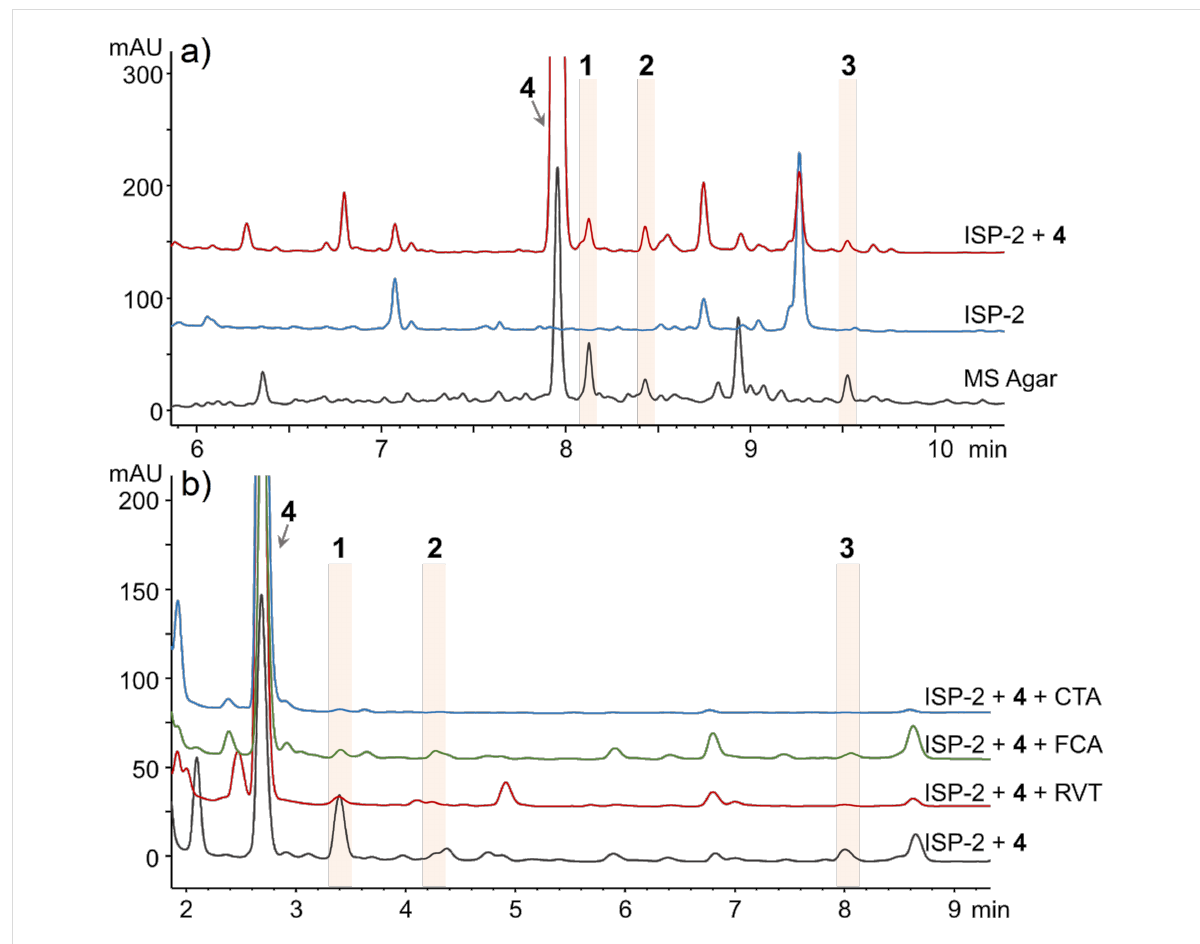
Figure 2: a) The culture in ISP-2 liquid did not produce 1 – 3 , while feeding with 4 restored the production (analytical method A according to Experi- mental section, 254 nm). b) Chemical genetics experiments indicated three P450 inhibitors could reduce the production of dimers derived from 4 (ana- lytical method B to better analyze the isoflavone region, 254 nm). CTA: clotrimazole (2.5 µM), FCA: fluconazole (1000 µM), RVT: resveratrol (100